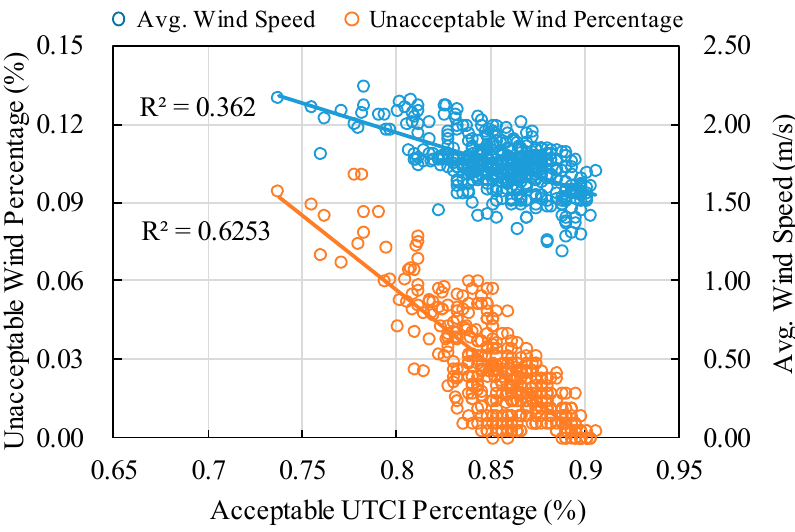
Figure 20. Correlation results of unacceptable wind percentage, avg. wind speed, and acceptable UTCI percentage at street level.